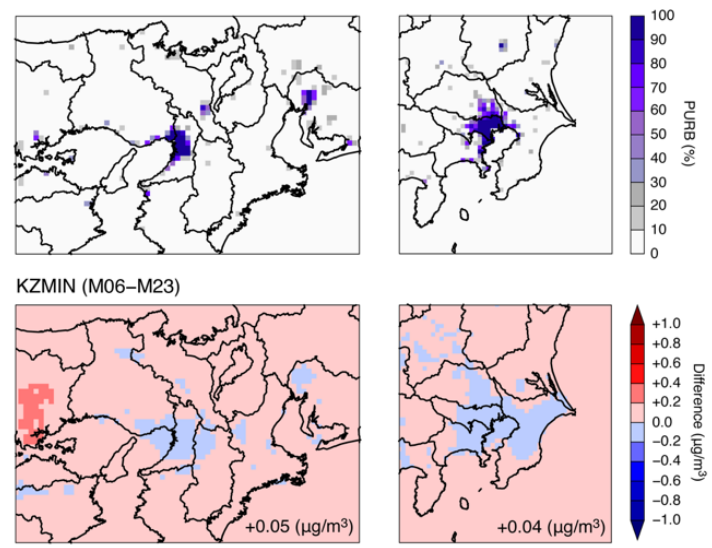
Figure 14. (Top) The mapping of PURB (the percentages of the urban fraction derived from the land use data) used in this study. (Bottom) Spatial distributions of difference due to the KZMIN option from the comparison of M06 and M23 over (left) domain 3 and (right) domain 4. The value shown in the lower-right side indicates the spatially averaged difference.